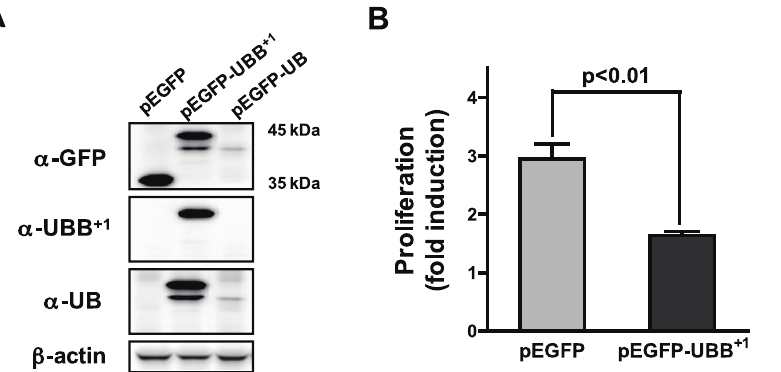
Figure 1. Ectopic expression of UBB + 1 in human astrocytic cell. (A) CRT-MG cells were stably transfected with pEGFP, pEGFP-UBB + 1 or pEGFP- UB constructs. Cell lysates were examined for EGFP, UBB + 1 or wild-type UB protein by immunoblot analysis. (B) Cells stably transfected with pEGFP or pEGFP-UBB + 1 constructs were plated on 60 mm 2 dishes (3 6 10 5 cells). After two days of culture, total cell number was counted after trypsinization. Proliferation rate was calculated as the fold induction of final cell number compared to the original cell number. Data are the mean 6 SD for quadruplicate samples from two independent experiments.